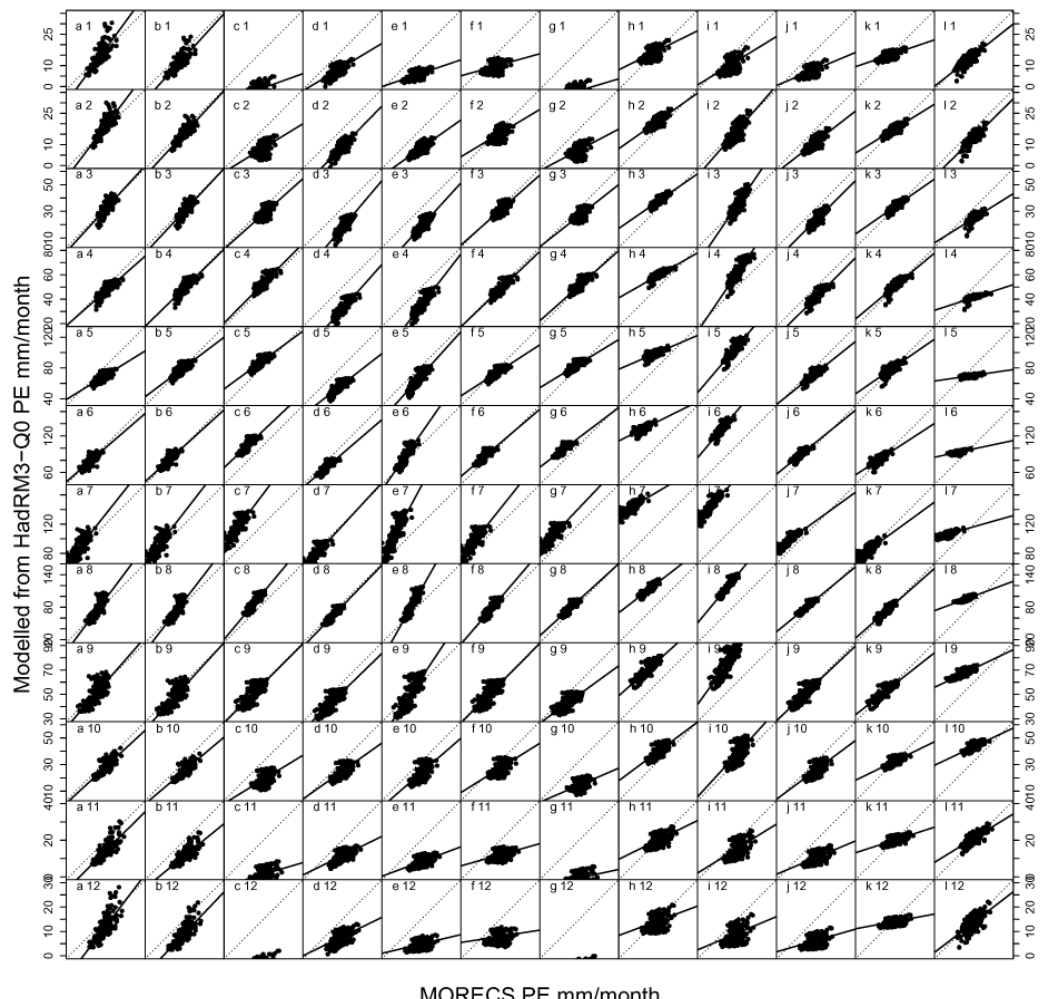
Fig. 1. Scatter plots of paired mean monthly MORECS and HadRM3-Q0-driven PET (mm/month) calculated over the 1961–1990 time slice for 12 PET equations (columns) and 12 months (lines). a: FA056; b: Penman–Monteith (mod); c: Priestley–Taylor; d: Turc; e: Jensen–Haise; f: Makkink; g: Priestley–Taylor (Idso–Jackson); h: Hamon; i: McGuinness–Bordne; j: Oudin; k: Blaney–Criddle; l: Thornthwaite. Month is given as 1 (January)–12 (December). Values are paired by MORECS grid. HadRM3-Q0-driven PET was calculated at the 5km grid scale and aggregated to the MORECS grid. The 1 : 1 line is the dotted line on each graph. Note variation of